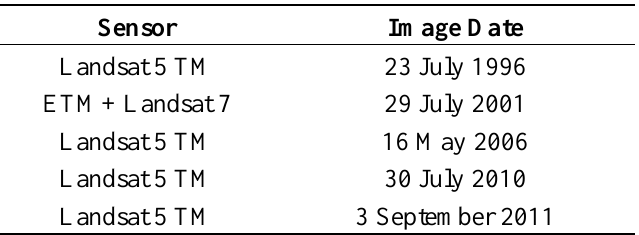
Table 4. Landsat image acquisition